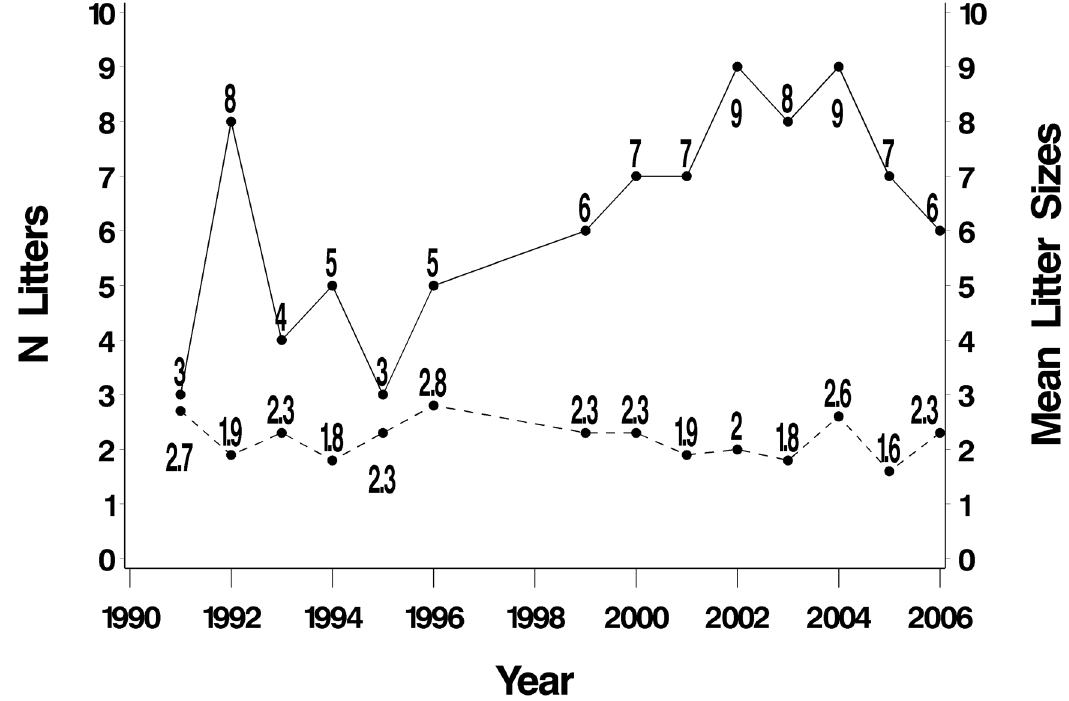
Figure 5. Trends in number of litters (solid line) and mean litter sizes (for those litters). doi:10.1371/journal.pone.0106202.g005 PLOS ONE |